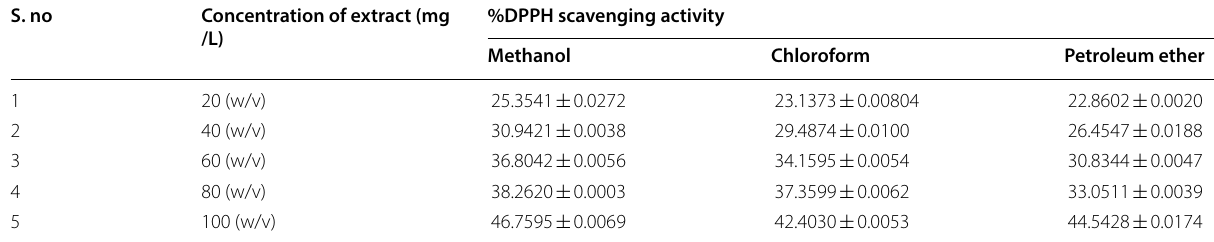
Table 3 DPPH radical scavenging activity of P. quadrifida extracts at different concentrations